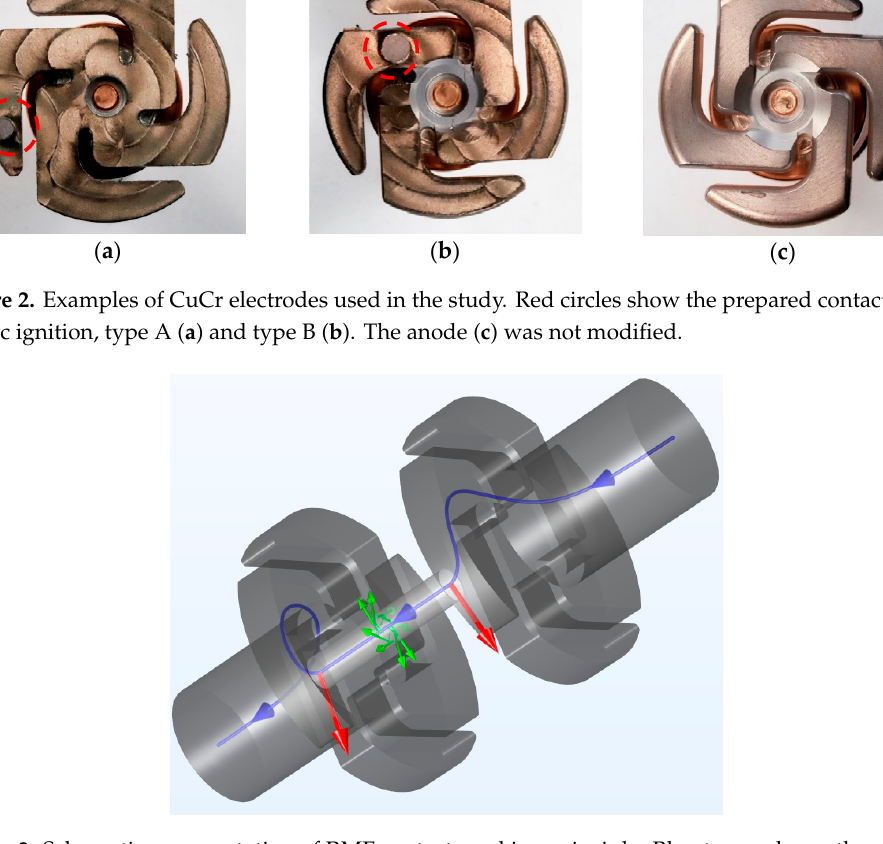
Figure 2. Examples of CuCr electrodes used in the study. Red circles show the prepared contact spots for arc ignition, type A ( a ) and type B ( b ). The anode ( c ) was not modified. These initial contact spots had diameters of about 3 mm. Only the cathodes were modified in order to reduce the influence on the anode as much as possible